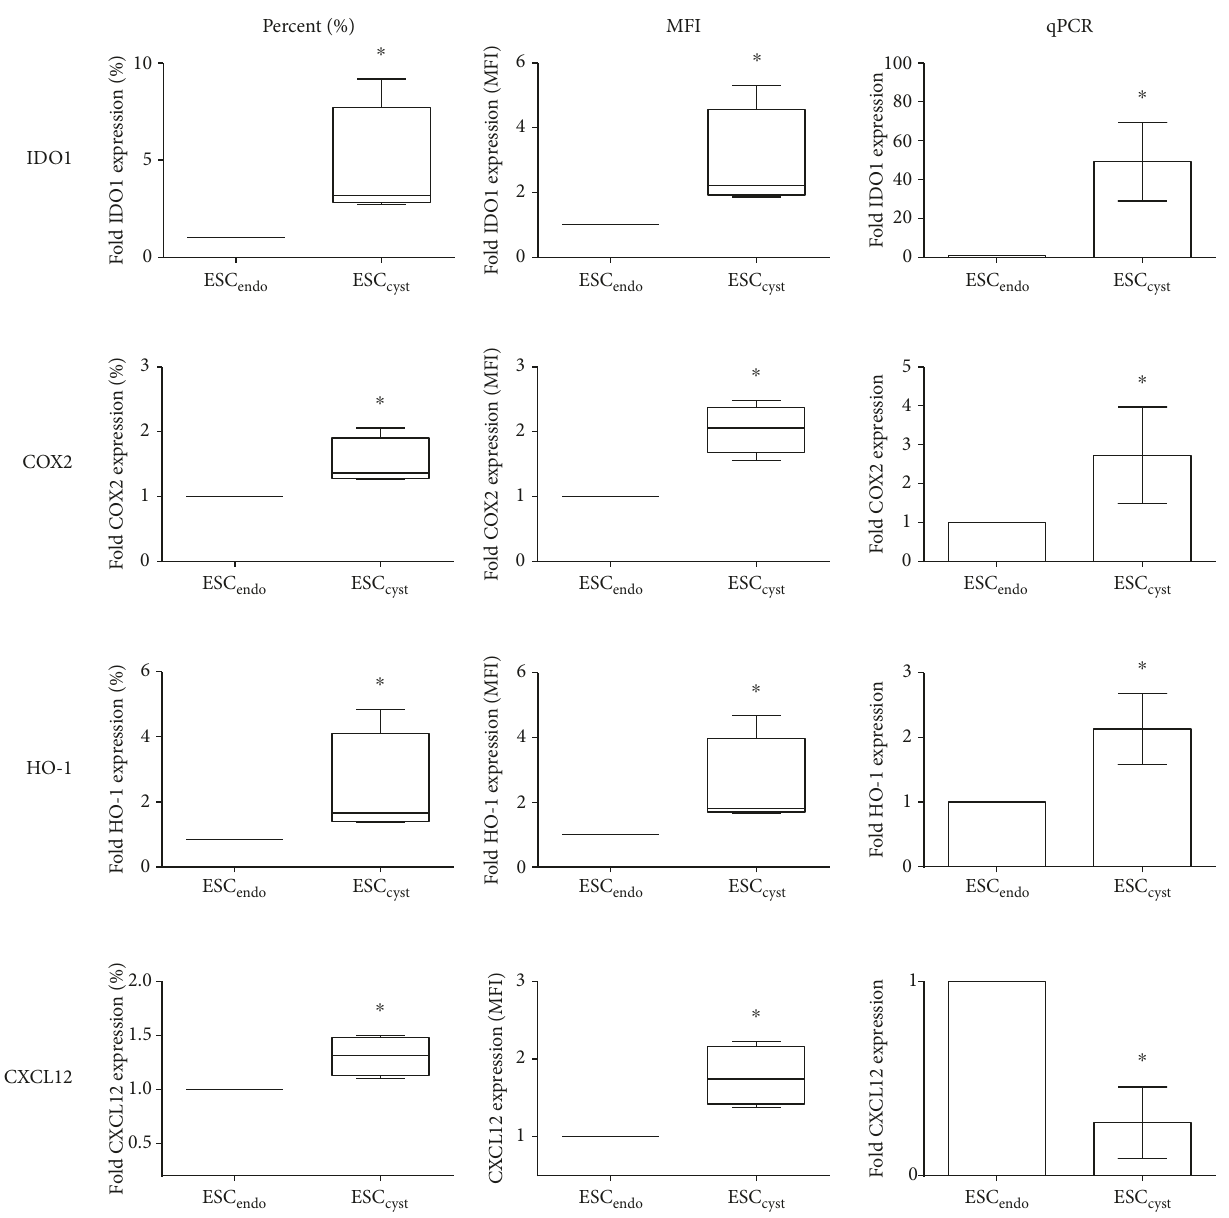
Figure 3: Protein and gene expression of the immunosuppressive enzymes IDO1, COX2, and HO-1 and the proin fl ammatory chemokine and ESC by fl ow cytometry and qPCR, respectively. The percentage of cells expressing IDO1 is higher for ESC CXCL12 in ESC endo cyst ( ∗ P < 0 05 ). ESC express higher levels of IDO1 by MFI ( ∗ P < 0 05 ). ESC have higher gene expression of IDO1 ( ∗ P < 0 05 ). The cyst cyst percentage of cells expressing COX2 is higher for ESC ( ∗ P < 0 05 ). ESC express higher levels of COX2 by MFI ( ∗ P < 0 05 ). ESC cyst cyst have higher gene expression of COX2 ( ∗ P < 0 05 ). The percentage of cells expressing HO-1 is higher for ESC express higher levels of HO-1 by MFI ( ∗ P < 0 05 ). ESC have higher gene expression of HO-1 ( ∗ P < 0 05 ). The percentage of cells cyst ( ∗ P < 0 05 ). ESC express higher levels of CXCL12 by MFI ( ∗ P < 0 05 ). ESC expressing CXCL12 is higher for ESC cyst cyst